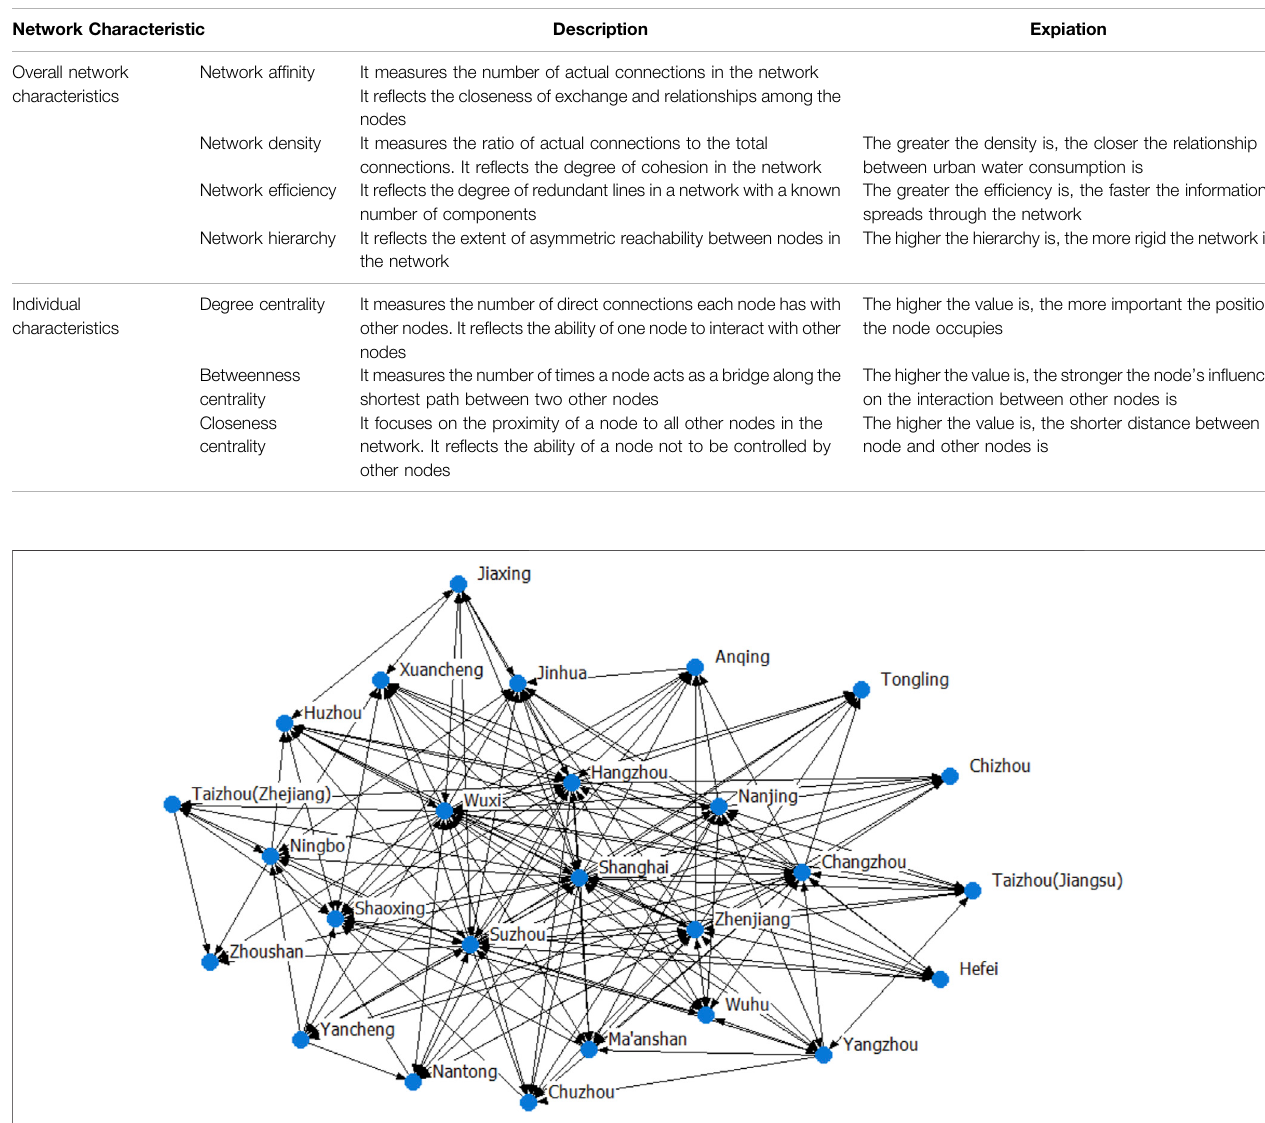
TABLE 1 | A brief description of the calculation methods of social network characteristics.